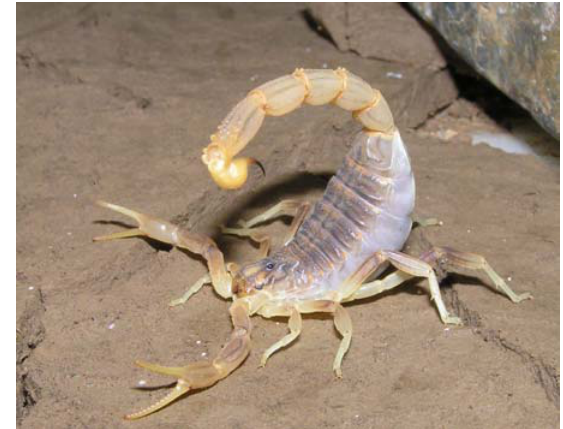
Figure 10. Female of Hottentotta hottentotta